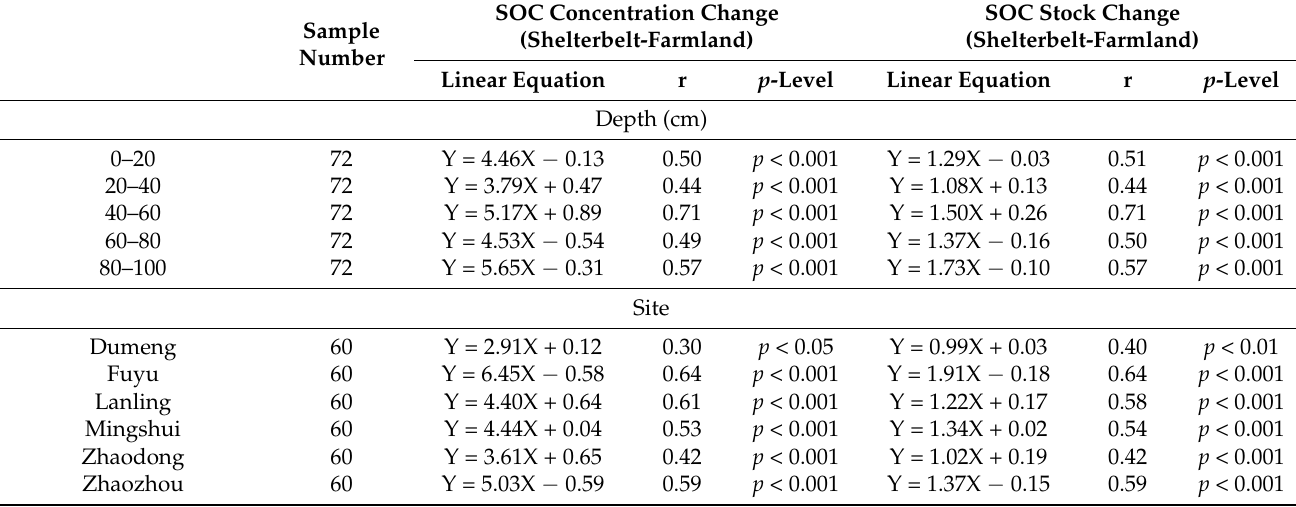
Figure 2. Correlations between total N content change(shelterbelt-farmland) and SOC changes (shelterbelt-farmland differences) at 0–100 cm. ( a ) in content; ( b ) in stocks. Correlations between poplar total N and poplar SOC at 0–100 cm. ( c ) in content; ( d ) in stocks. Correlations between farmland total N and farmland SOC at 0–100 cm. ( e ) in content; ( f ) in stocks. Table 7. Differences in the total N-SOC sequestration potential relations in different soil layers and